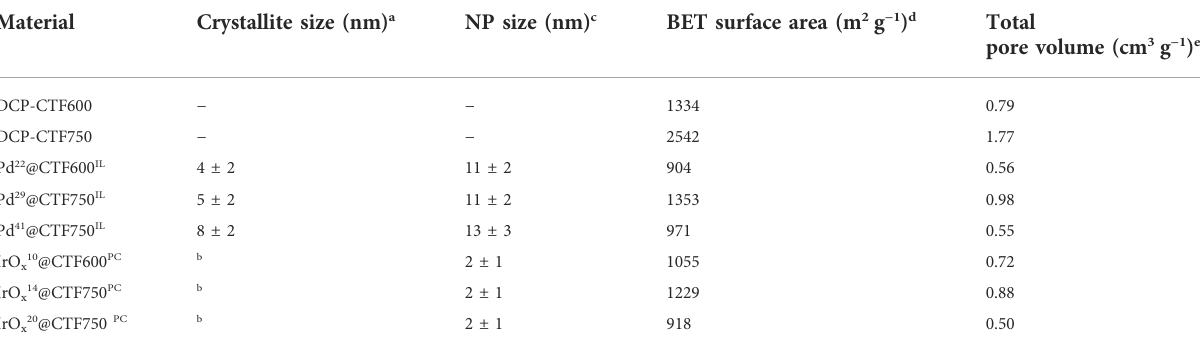
TABLE 2 Average crystallite and particle sizes and porosity of Pd- and IrO x @CTF materials.